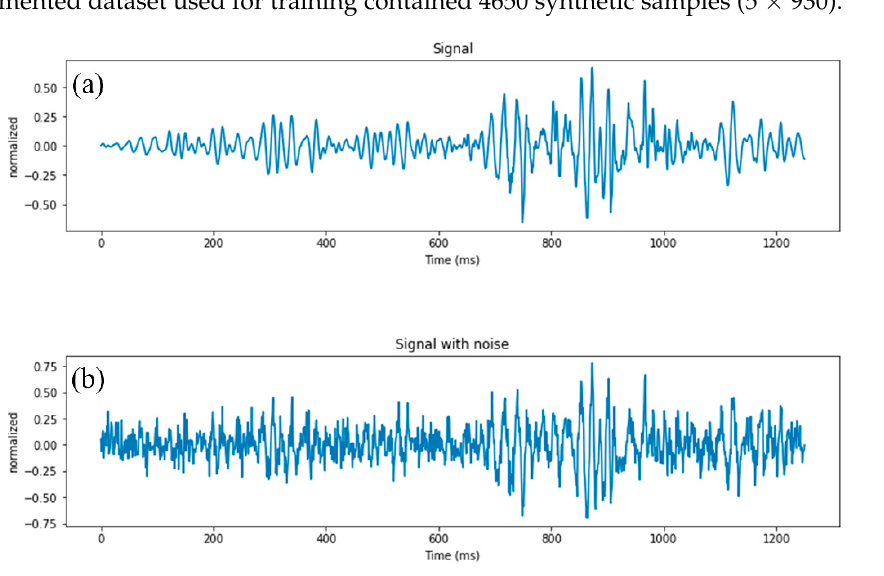
Figure 5. ( a ) Seismic signal of a bus before adding noise. ( b ) Seismic signal after adding noise to produce a signal to noise ratio of